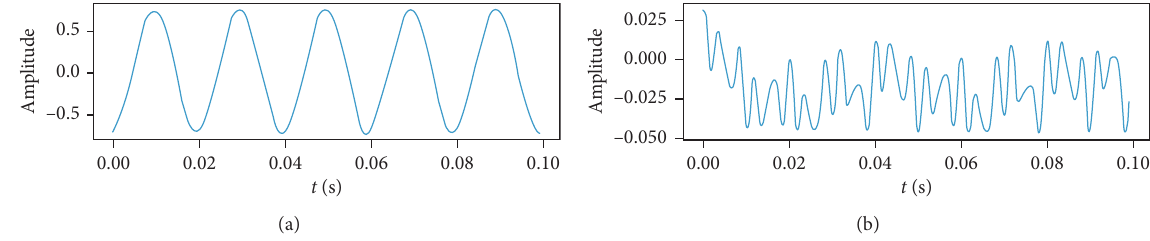
Figure 5: Different reconstructed signals from the components. (a) Supply frequency signal and (b) residual signal.